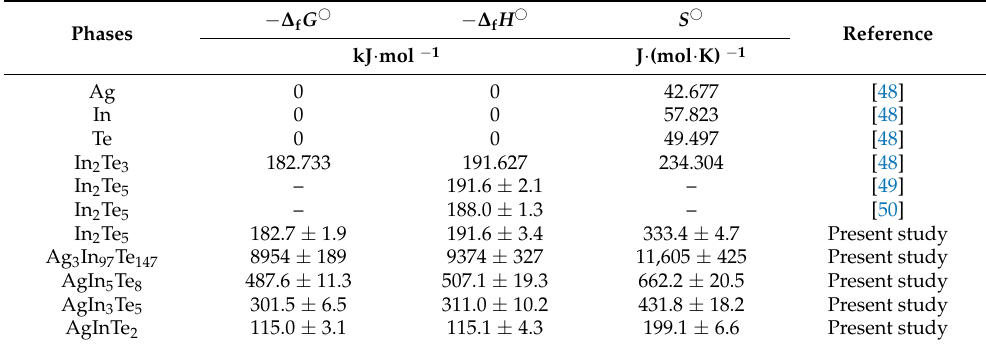
Table 4. The standard thermodynamic quantities of elements and compounds in the Ag–In–Te